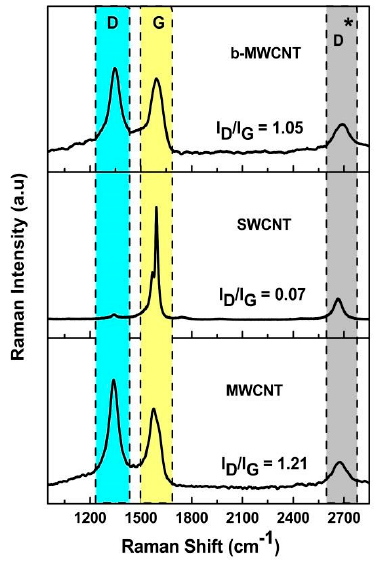
Figure 2. Raman spectra of the different carbon nanotube (CNT) types.